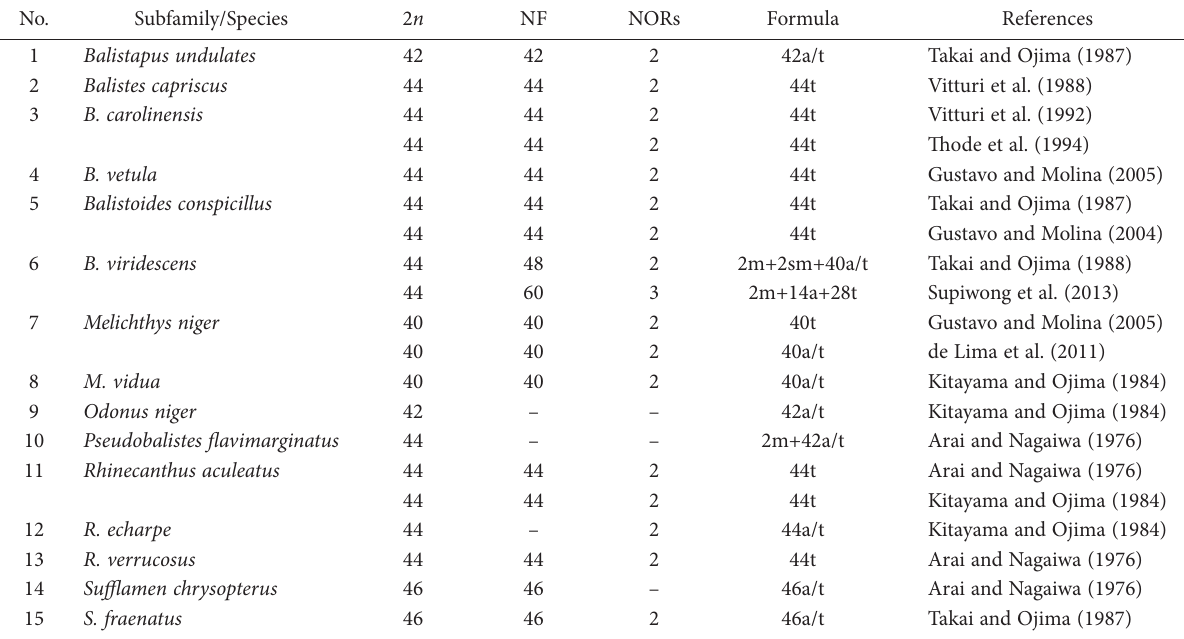
Table 1. Cytogenetic reviews of the family Balistidae (8 genera).